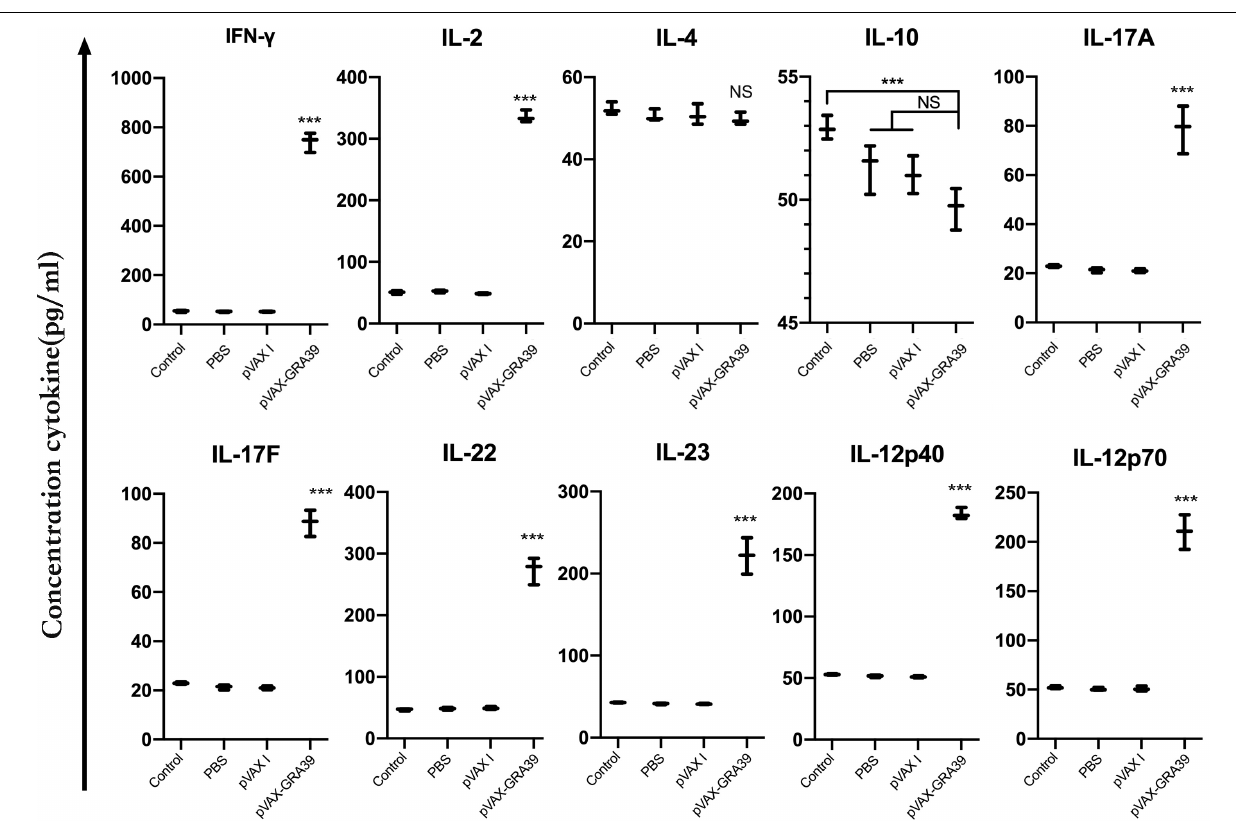
T. gondii RH strain and the chronic T. gondii PRU